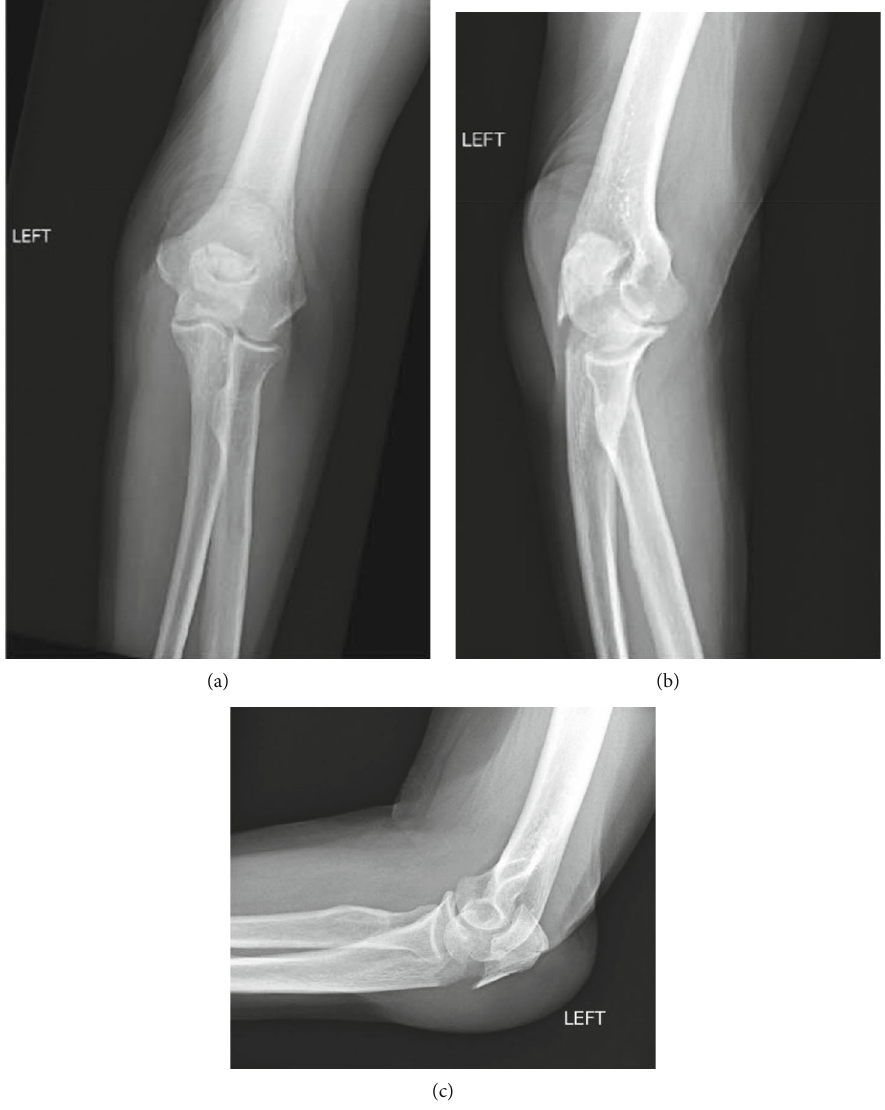
Figure 1: Preoperative AP (a), oblique (b), and lateral (c) radiographs demonstrating a displaced and comminuted left olecranon